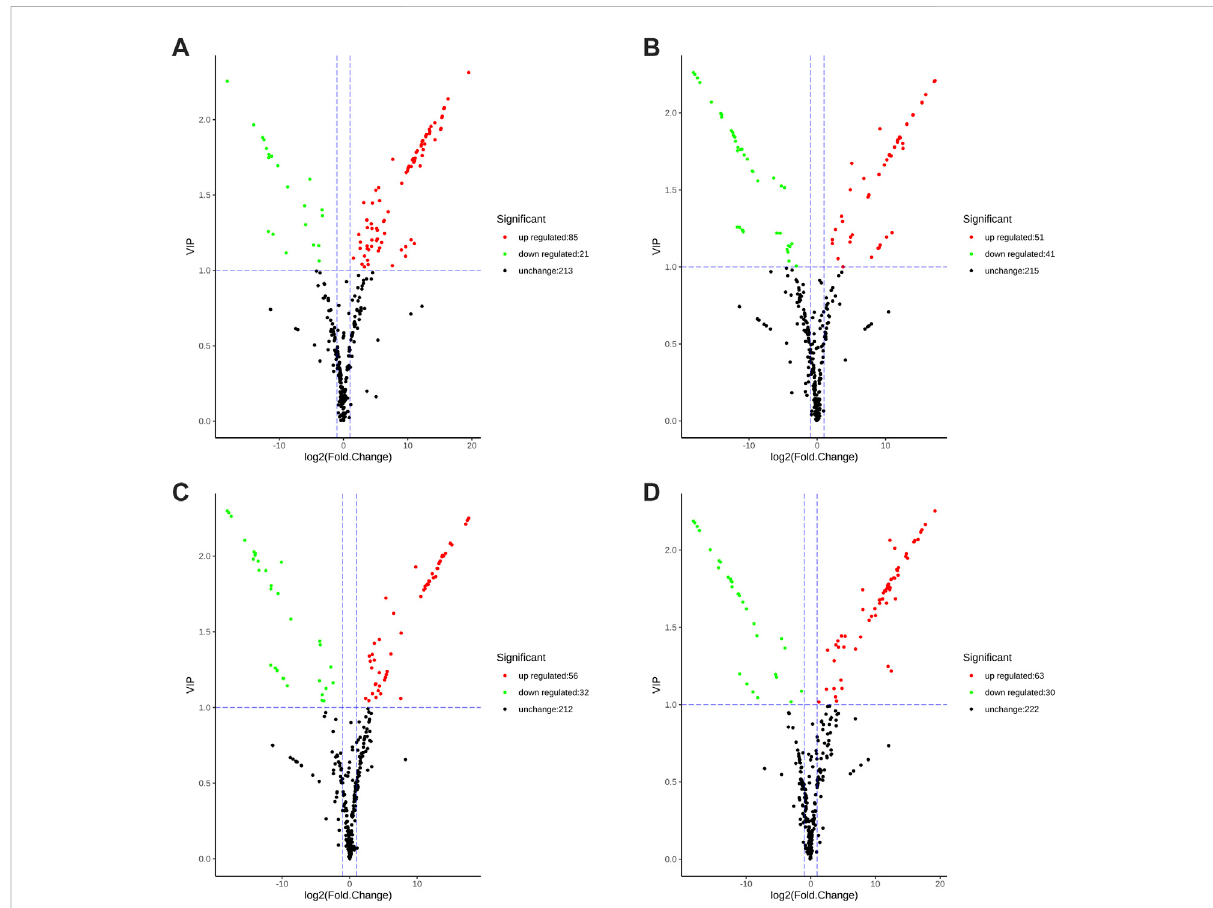
FIGURE 3 Volcanic plots of the differential metabolites in the comparison of SGHJ versus HJ (A) , SGHJ versus DHJ (B) , SGHJ versus DYHJ (C) , and SGHJ versus DHHJ (D) , respectively. Red dots mean upregulated, green dots mean downregulated, and black dots mean no change. SGHJ: